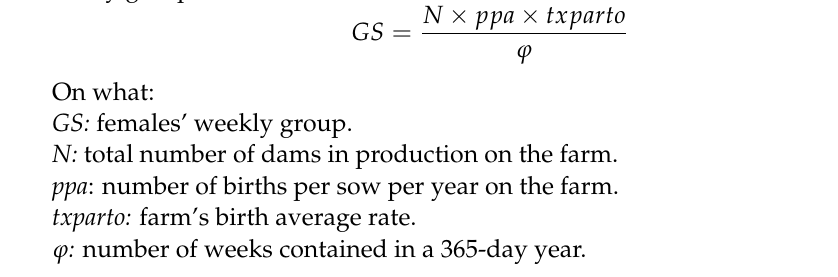
Table 1. Scheme adopted for allocation of swine production